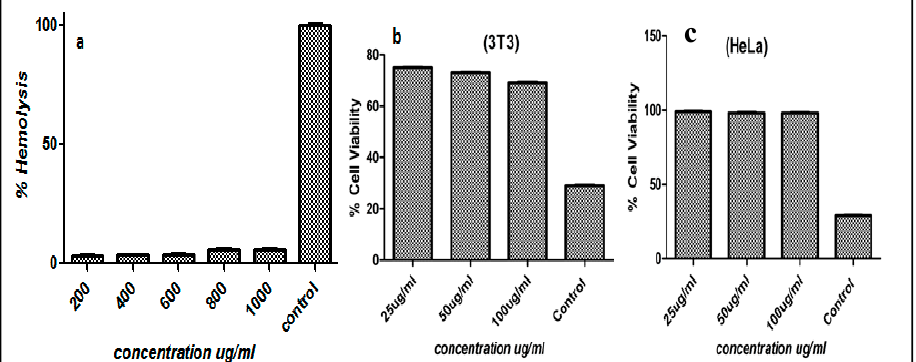
Figure 4. ( a ) Percent hemolysis of MIH-MP nanoparticles at different concentrations. ( b ) In vitro cytotoxicity profile of MIH-MP nanoparticles against 3T3(NIH) and ( c ) HeLa cell lines.